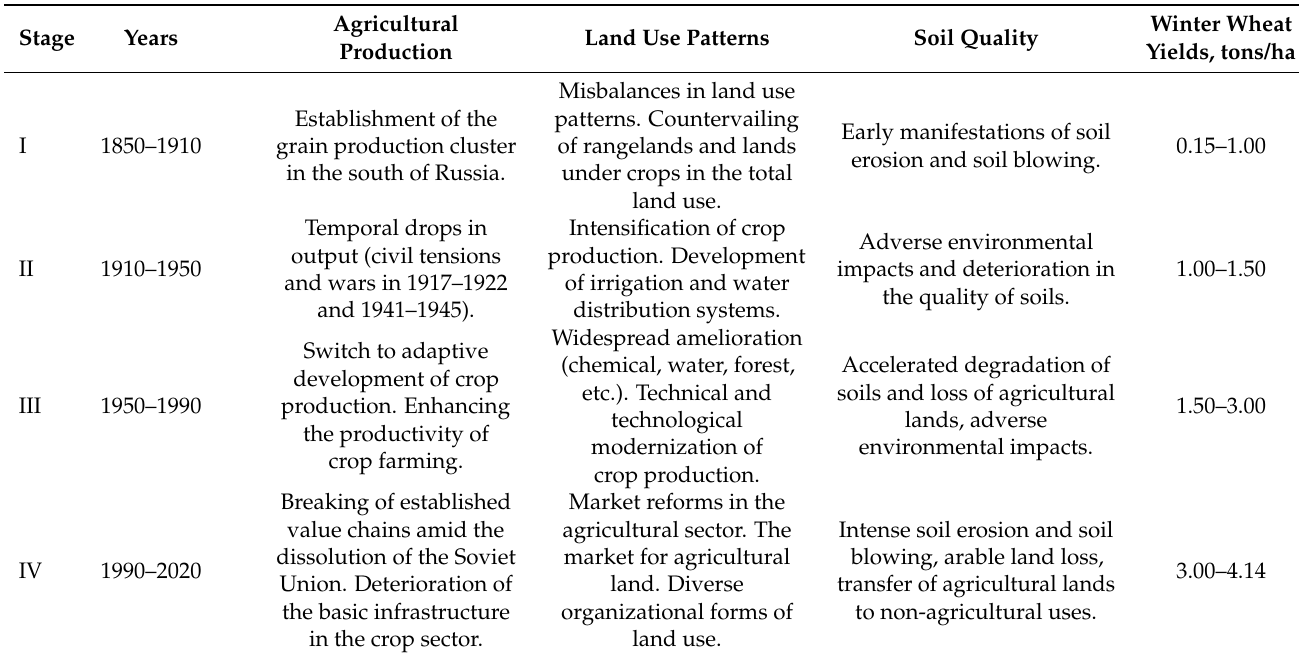
Table 1. Periods under